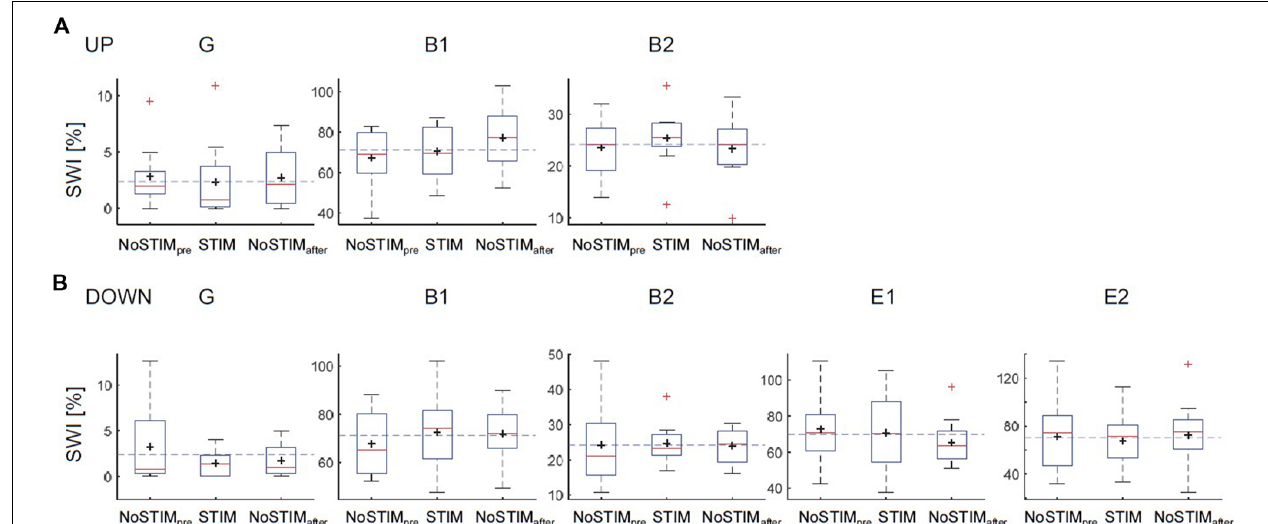
FIGURE 2 | Effects on the spike-wave index (SWI) of the acoustic stimulation during the up-phase (A) or the down-phase (B) of slow waves for each patient. Boxplot: the middle red line indicates the median, the black cross indicates the mean, the bottom and top of the box indicate the first (Q1 = 25th percentile) and third quartiles (Q3 = 75th percentile), whiskers extend to indicate 1.5 × the IQR (IQR = Q3 − Q1), red crosses correspond to values outside the whisker range. The dashed blue line indicates the mean SWI over all blocks [i.e., for ESES NoSTIM pre&after , STIM down ; for BECTS and generalized spike waves in sleep electroencephalographic (EEG): NoSTIM pre&after , STIM down&UP ]; G, generalized spike waves in sleep EEG; B, BECTS; E, ESES.